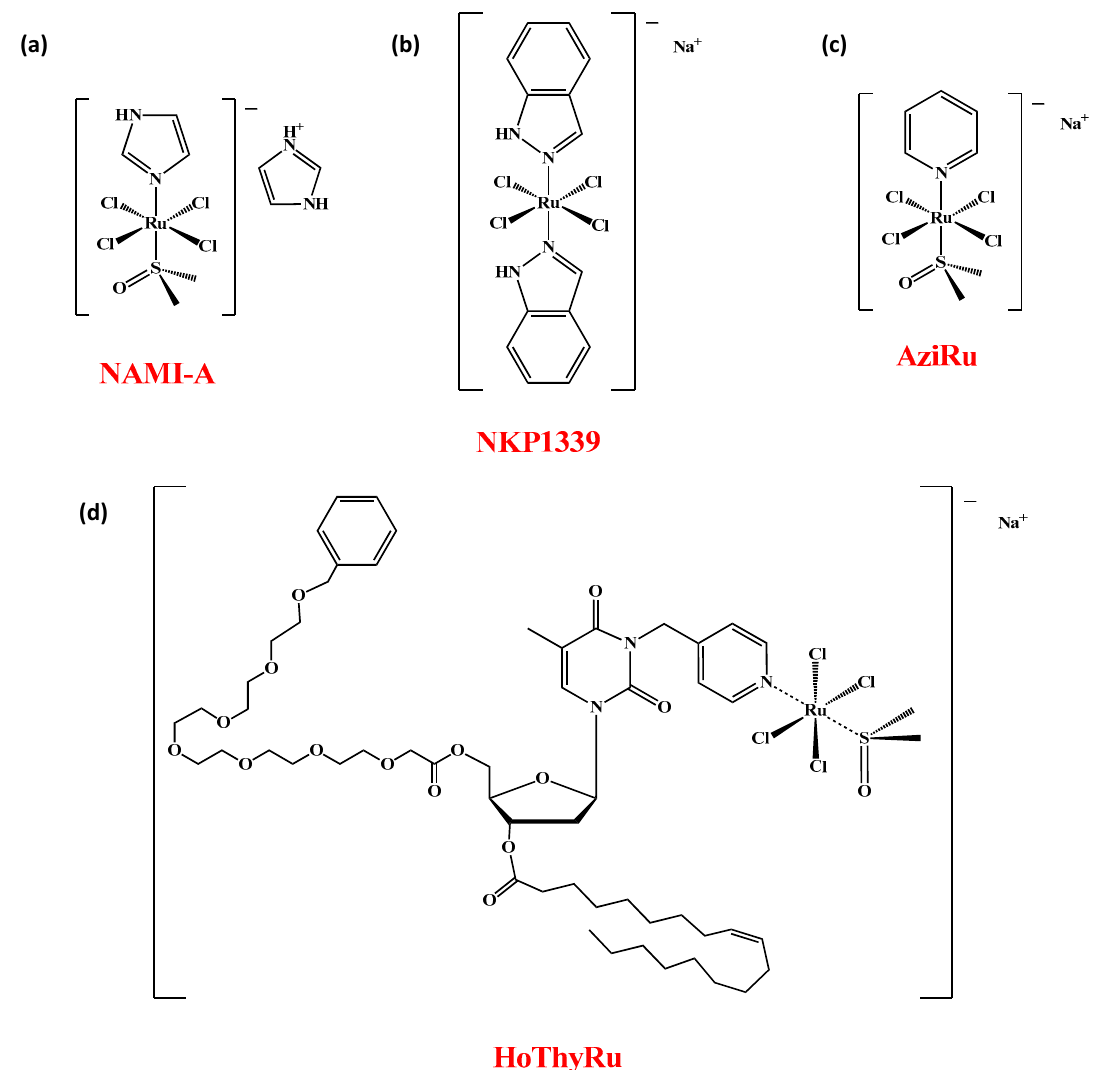
Figure 1. Molecular structures of the low molecular weight ruthenium complexes NAMI-A ( a ), NKP1339 ( b ), AziRu ( c ), and of the HoThyRu nucleolipid-based complex ( d ) incorporating AziRu.